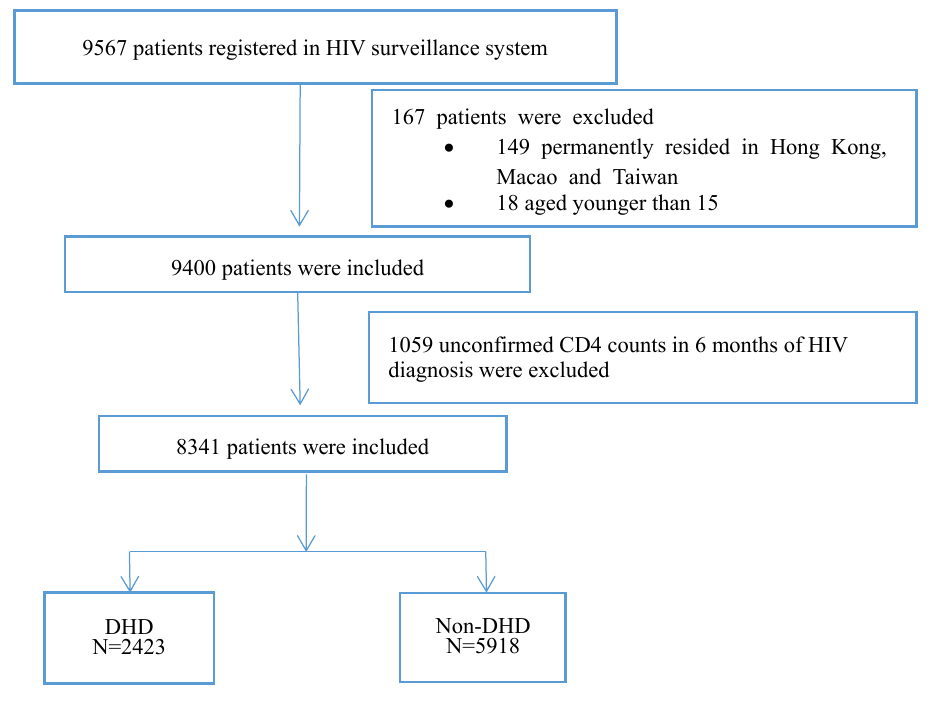
Figure 1. Flow chart of DHD analysis.